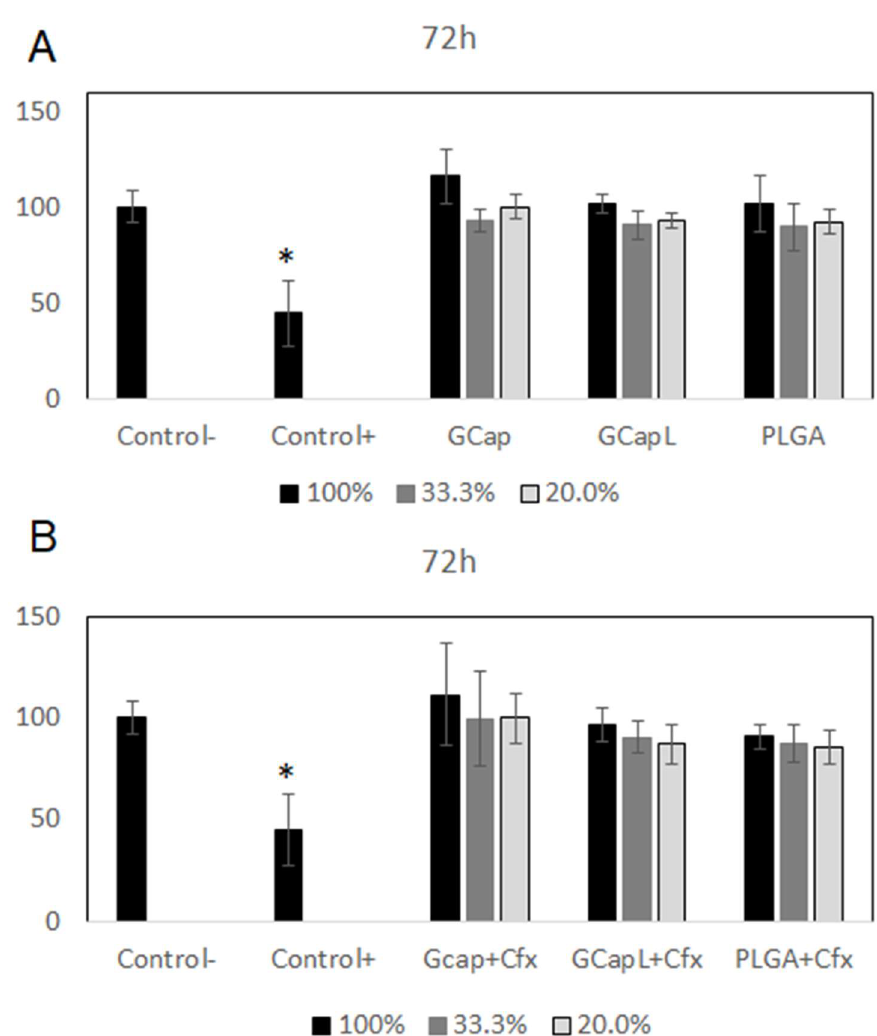
Figure 6. Effect of extracts obtained after 72 h of incubation of the samples with drug-free polymer coatings ( A ) and polymer coatings containing ciprofloxacin ( B ) on the proliferation of cells ( * p < 0.05 versus the control group).